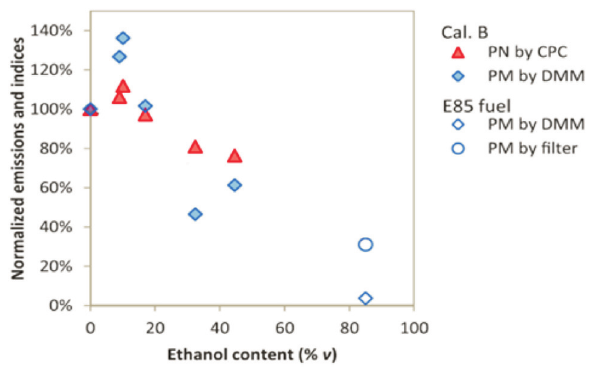
Fig. 8. Vehicle PN emissions and PM emissions by DMM and by filtra - tion, on FTP cycle for vehicle calibration B [21]